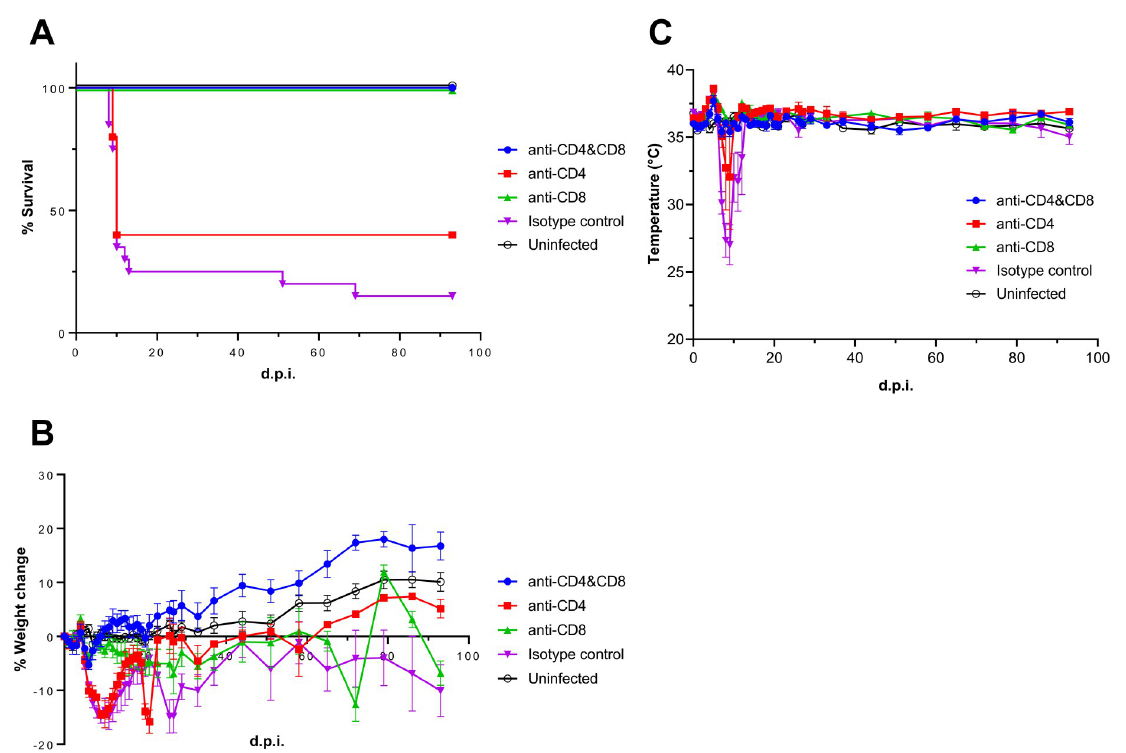
Fig 3. Pathogenicity of LASV in T-cell depleted Stat1-KO. Survival rate (A) , body weight change (B) , and body temperature (C) of T-cell- depleted Stat1-KO mice were plotted. Stat1-KO mice were injected with anti-CD4 and/or CD8 mAbs at 3 or 1 day prior to LASV infection in order to deplete CD4 and/or CD8 T-cells (n = 5). Mice in the isotype control group were injected with the isotype control mAb at 3 or 1 day prior to LASV infection (n = 20). Mice in the uninfected group were injected with the isotype control mAb at 3 or 1 day prior to PBS injection (n =